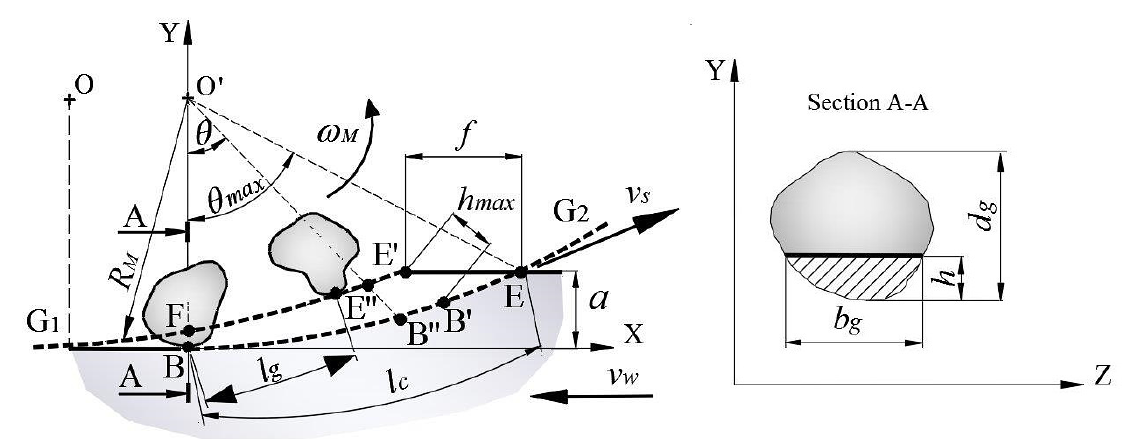
Figure 1. Characteristics of interaction between grinding wheel and